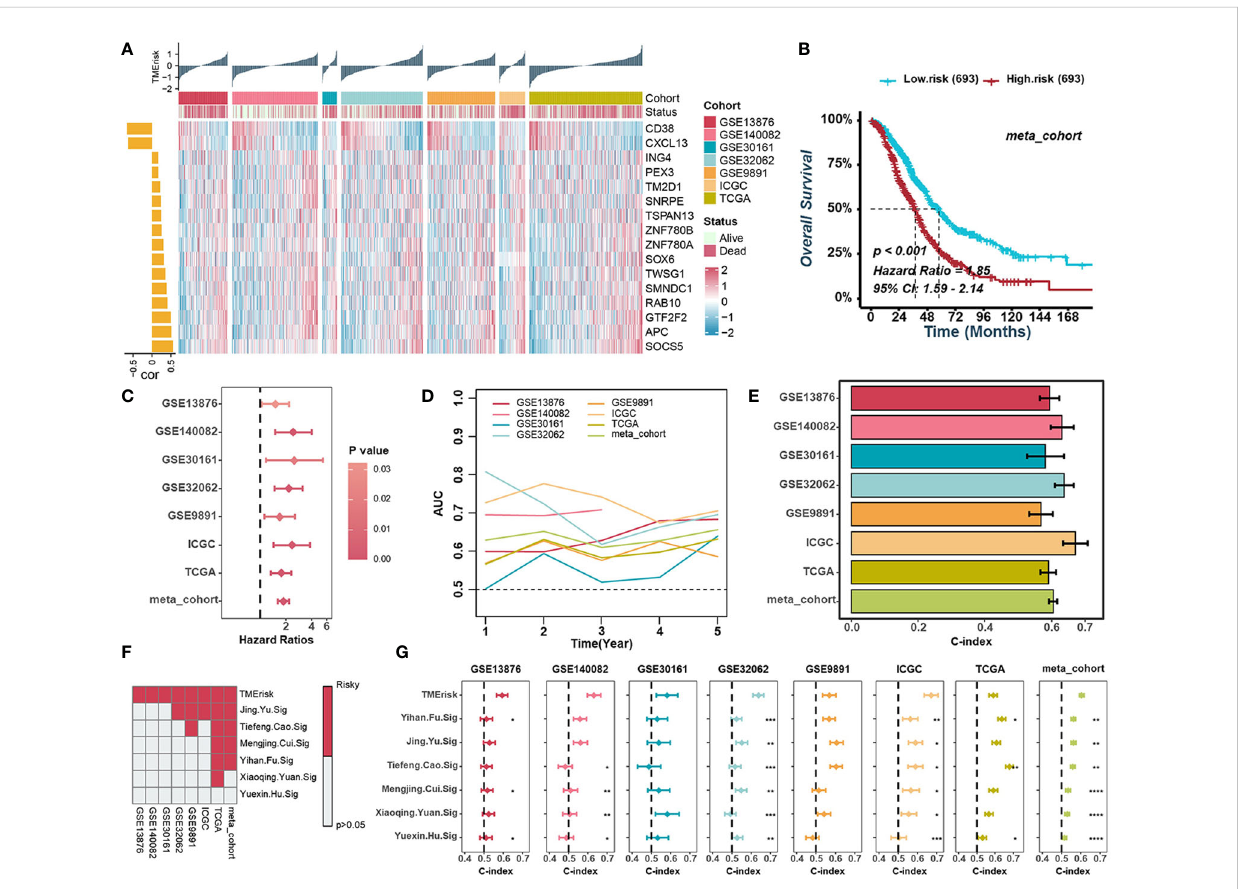
FIGURE 2 Construction of the TMErisk score in HGSOC. (A) Heatmap illustrating the expression of 16 TME-related genes and the TMErisk score in low- and high-TMErisk groups. The bar chart on the left illustrates the relationships between TME-related genes and TMErisk score. (B) Kaplan-Meier analysis estimating the overall survival between low- and high-TMErisk groups in meta-cohort. (C) Univariate Cox regression analyses revealing the correlation between TMErisk score and HGSOC survival. (D) Time-dependent AUC value of the TMErisk score in different cohorts. (E) C-index of the TMErisk score in different cohorts. (F) Univariate Cox regression analysis of the TMErisk score and other published signatures across diverse cohorts. (G) C-index of the TMErisk score and other published signatures across diverse cohorts. * P < 0.05; ** P < 0.01; *** P < 0.001; **** P <